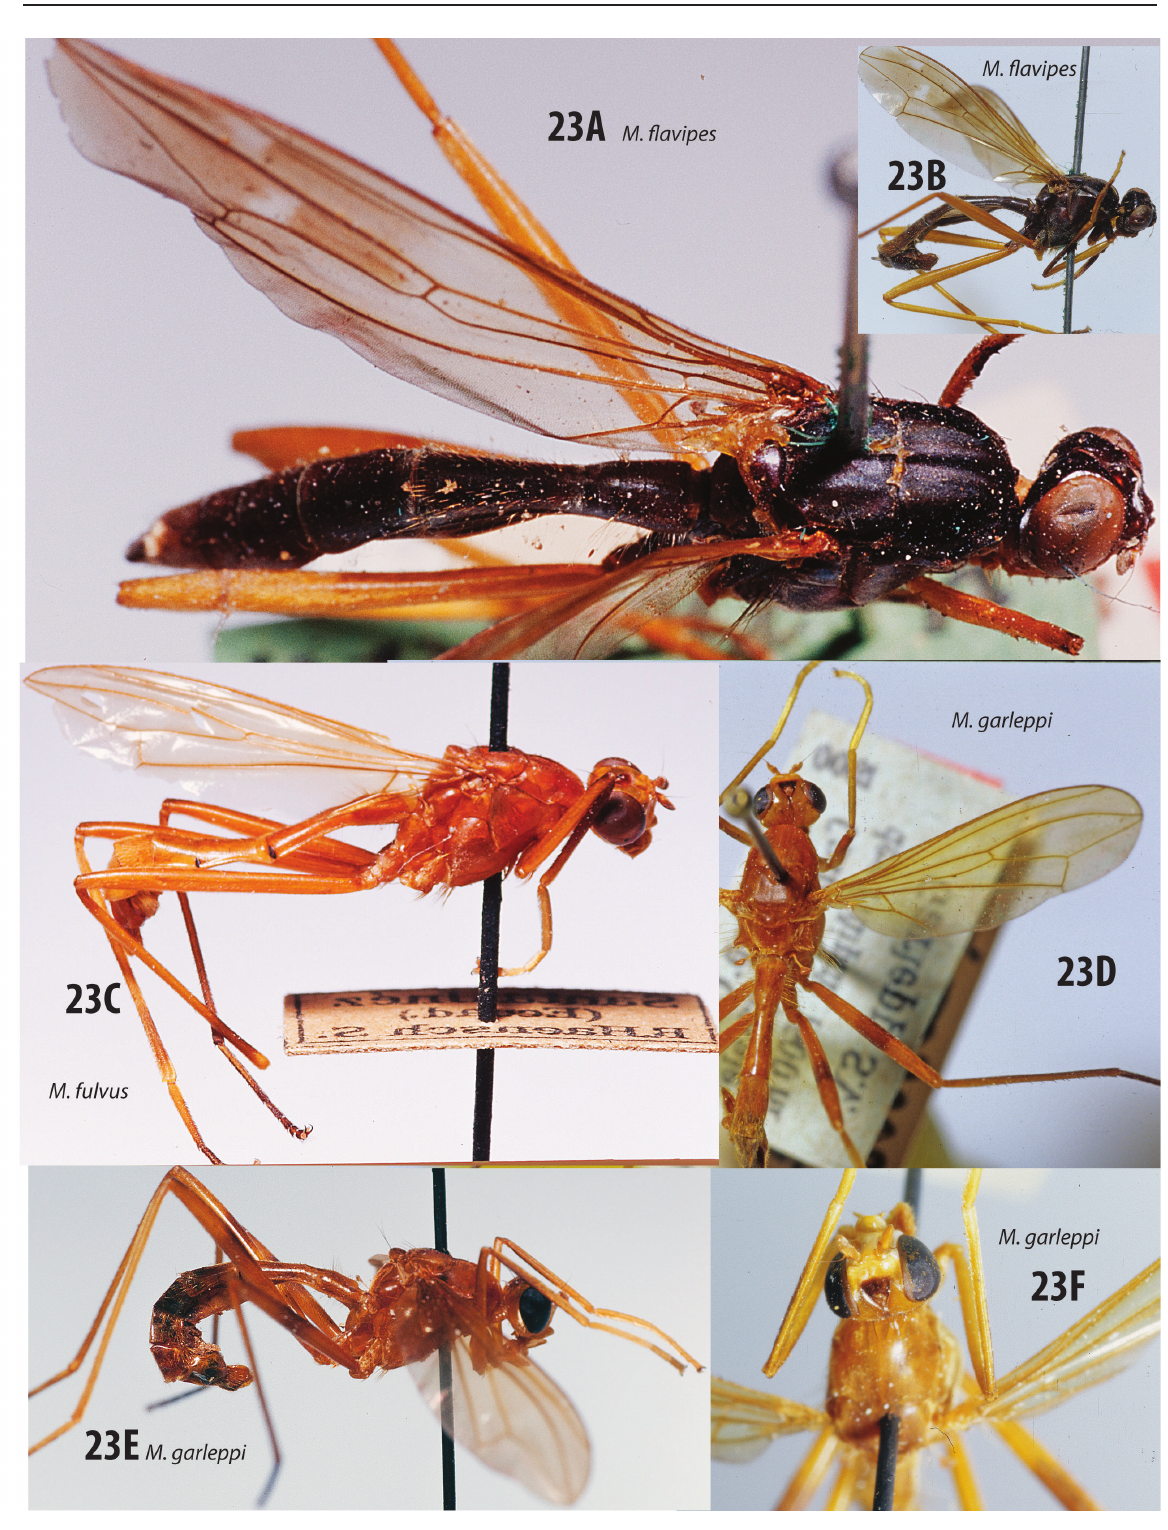
Fig. 23. A–B . Mesoconius flavipes Enderlein, 1922, holotype, ♂, MNBG. — C . M. fulvus Enderlein, 1922, holotype, ♂, MNBG. — D–F . M. garleppi Enderlein, 1922, holotype, ♂,